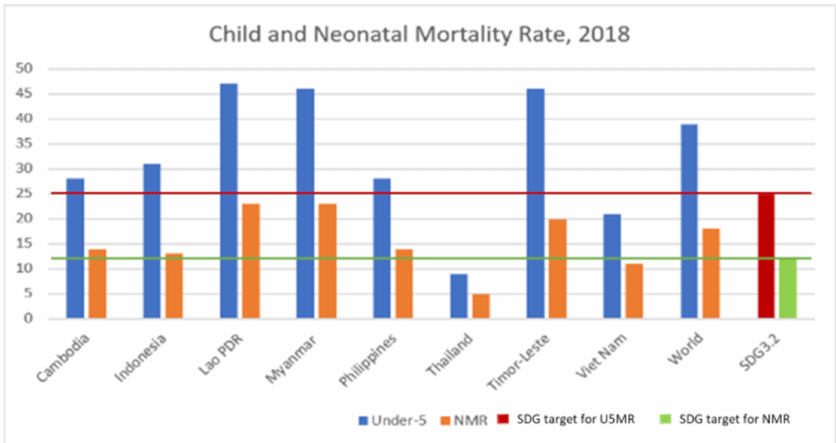
Figure 1. Child and neonatal mortality per 1000 live births in 2018, selected countries in the South East Asia region. Data source: Levels and trends in child mortality 2019, UNICEF, WHO, World Bank Group and United Nations